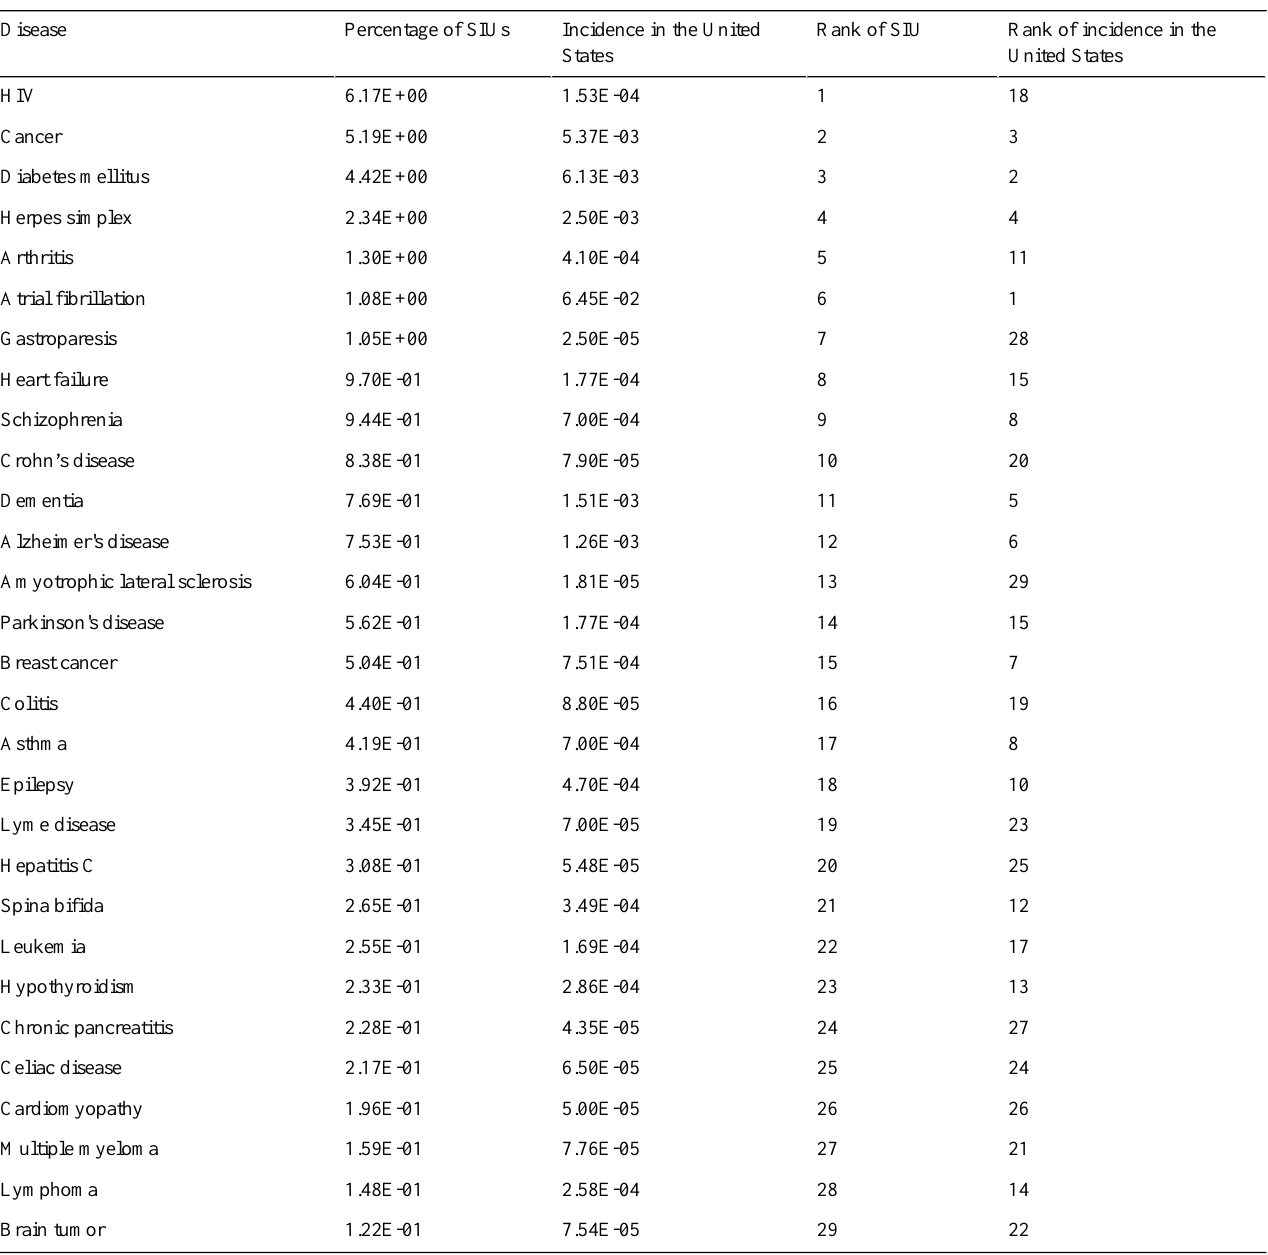
Table 1. Disease incidence a in the United States and in the self-identified user (SIU) population for 29 diseases.